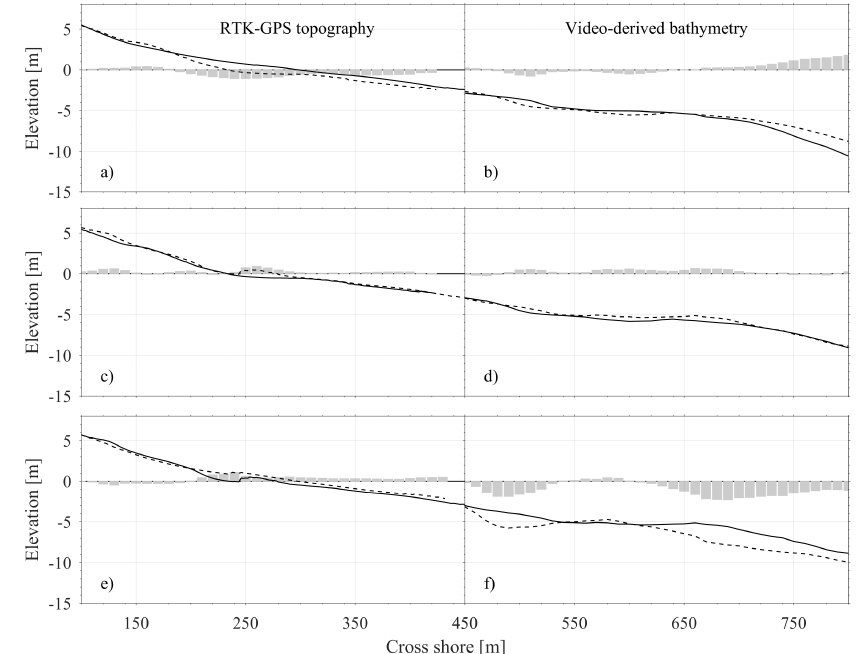
Figure 8. Alongshore averaged profiles partially computed using the inter-tidal beach surveys ( a , c , e ) and video-derived bathymetries ( b , d , f ). The dates used: ( a , b ) show 5 November 2013 (solid) and 30 April 2014 (dashed), ( c , d ) represent 30 April 2014 (solid) and 13 September 2014 (dashed) and plot ( e , f ) show 13 September 2014 (solid) to 5 December 2015